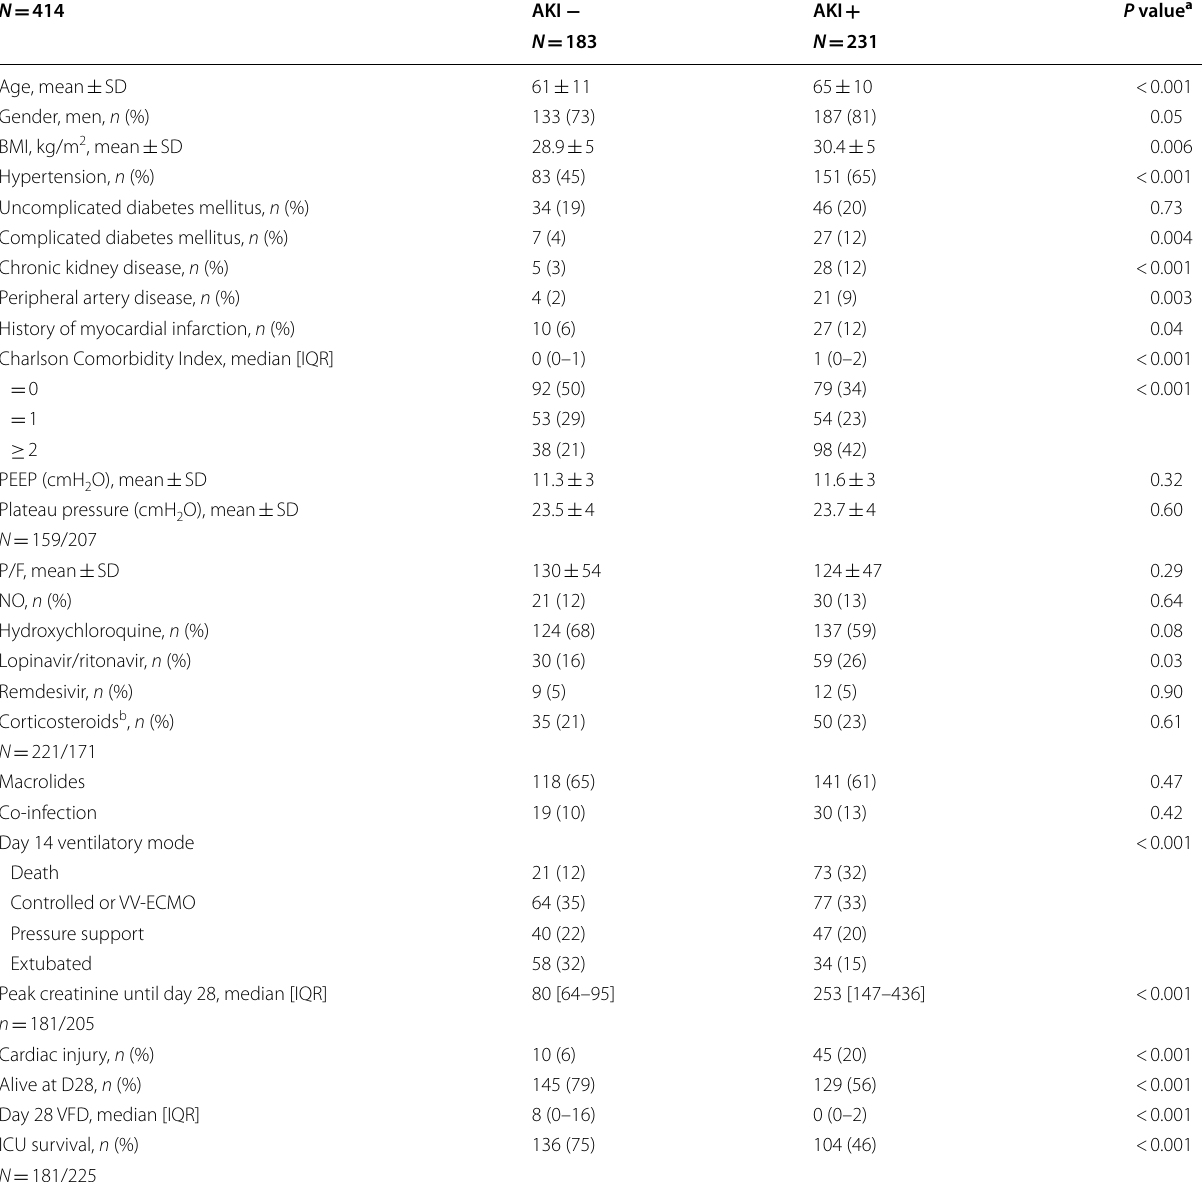
Table 3 Associated factors with AKI within 28 days after